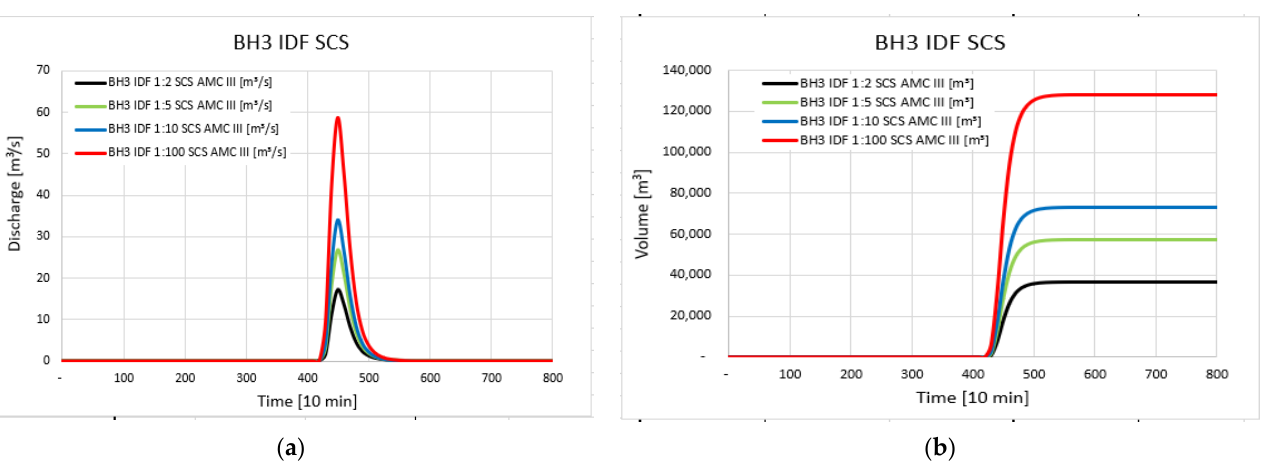
Figure 21. Design flood hydrographs in Hypothesis 1: ( a ) discharges and ( b ) flood volumes. Table 1. Characteristics of the Design Flood Hydrograph in BH_3, Hypothesis 1.